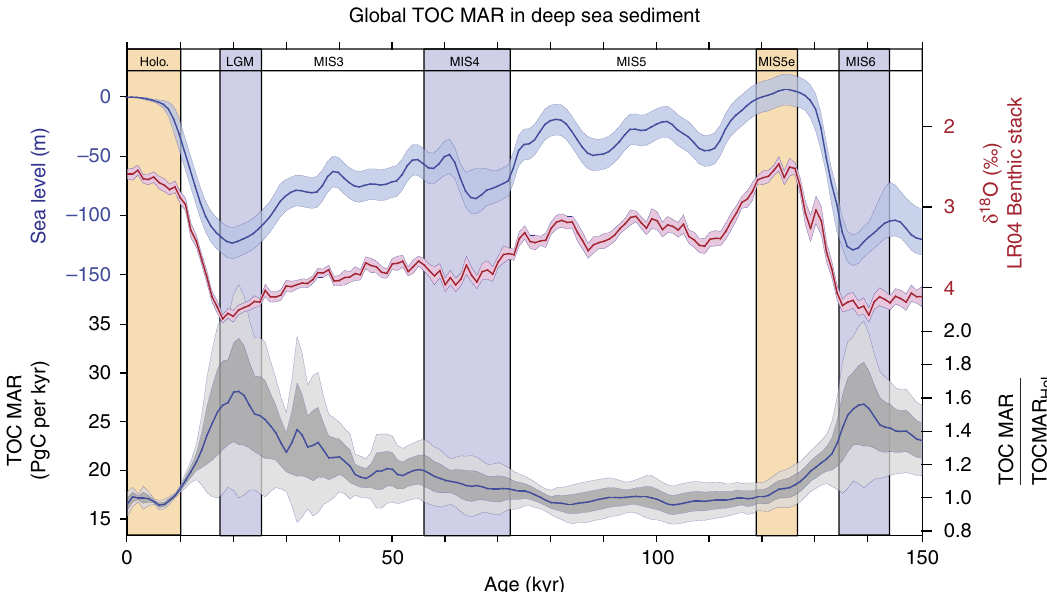
Figure 2 | Global TOC burial over the past 150 kyr. Sea-level reconstruction (and associated confidence interval 50 ; LR04 benthic foraminifera d 18 O stack 51 ( ± 2 s.e.), and reconstructed global organic carbon burial in deep-sea sediment over the past 150 kyr (PgC per kyr, ± 1 s , ± 2 s and mean scenario based on the different province scenarios, see Methods, Supplementary Fig. 2 and Supplementary Data 1). The right axis shows relative changes in TOC MAR as compared with Holocene values. The mean organic carbon burial is significantly correlated to both the sea-level reconstruction and the benthic stack ( R ¼ 0.85, P oo 0.05 and R ¼ 0.77, P oo 0.05, respectively). Yellow vertical bands correspond to interglacial periods (Holocene and Marine Isotopic Stage (MIS) 5e), blue vertical bands correspond to glacial condition (Last Glacial Maximum (LGM), MIS4 and